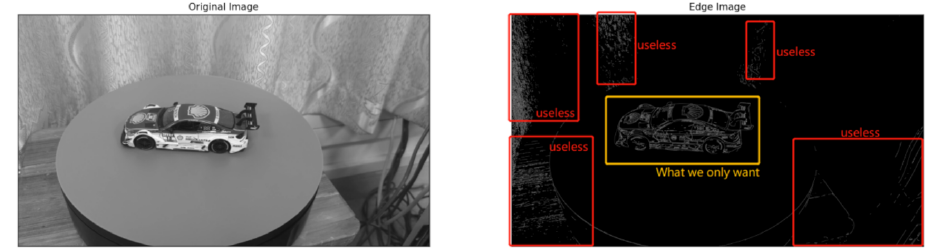
Figure 1. The matting result of the Canny